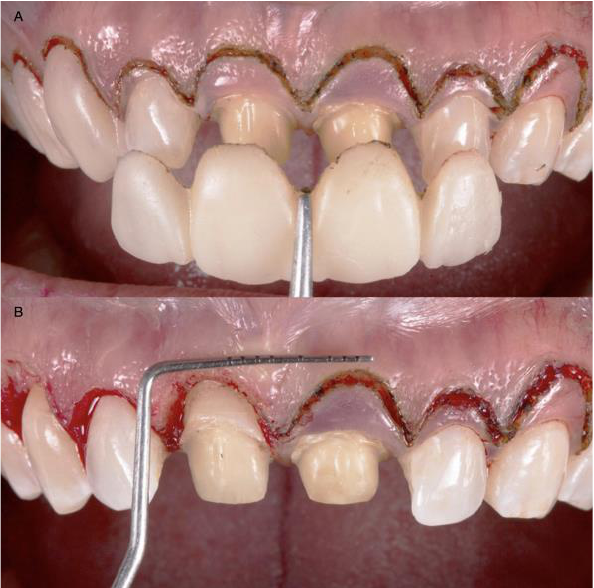
Figure 4. Diagnostic overlay removal and evaluation: ( A ) Removal of the diagnostic overlay; ( B ) Gingival tissue architecture evaluation. ( B ) Gingival tissue architecture evaluation.